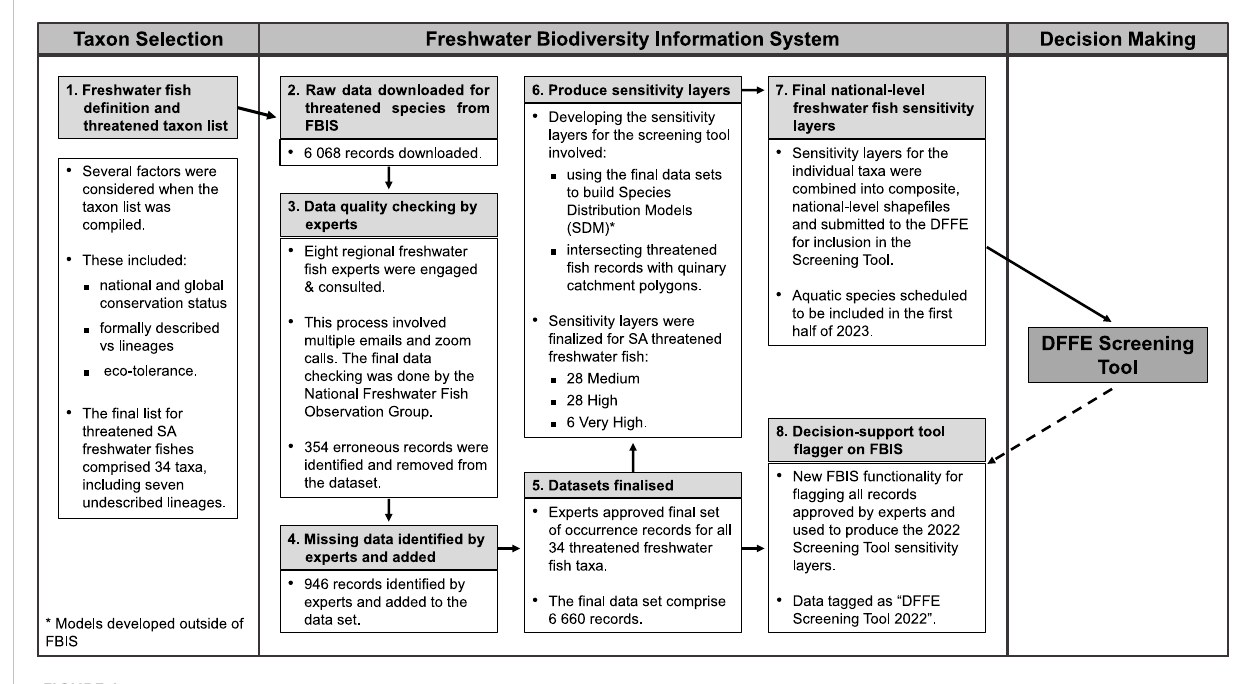
FIGURE 1 Schematic illustrating the data fl ow from the Freshwater Biodiversity Information System (FBIS) into the Department of Forestry, Fisheries and Environment (DFFE) Screening Tool and for developing the necessary functionality to improve the ease of future such projects.